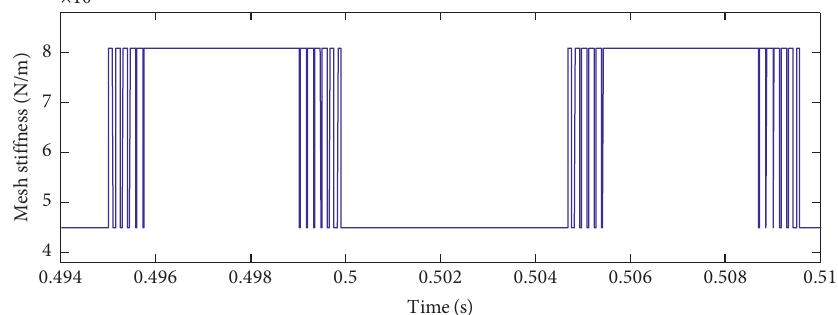
Figure 6: Meshing stiffness of s- p